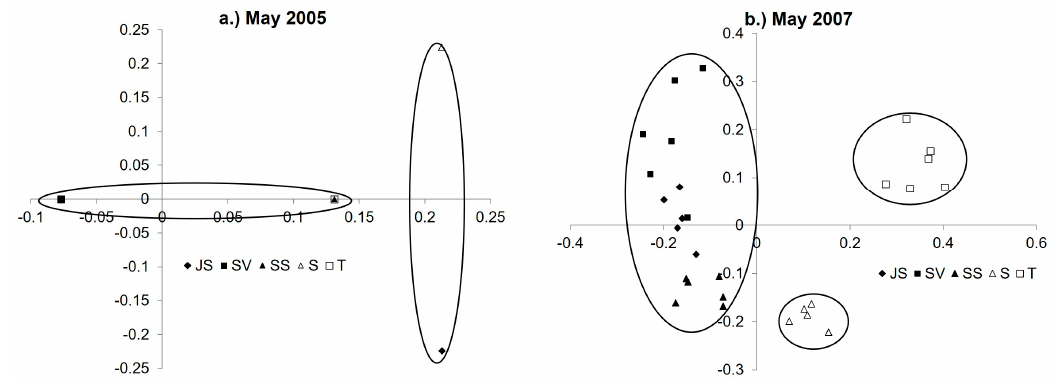
Figure 3. PCA results for dates ( a ) May 2005 and ( b ) 2007 (JS, SV, SS, S and T). Circles denote significance ( p < 0.001) for clustering. For May 2005 Axis 1 represents 61.3% of the variance and Axis 2 represents 84.8% of the variance. For May 2007 Axis 1 represents 31.2% of the variance and Axis 2 represents 52.1% of the variance. Vegetation zone designations: Juncus roemerianus stand (JS); Salicornia virginica (SV); mixed plant zone of co ‐ occurring S. virginica and short form Spartina alterniflora (SS); short form S. alterniflora (S); and tall form S. alterniflora (T).